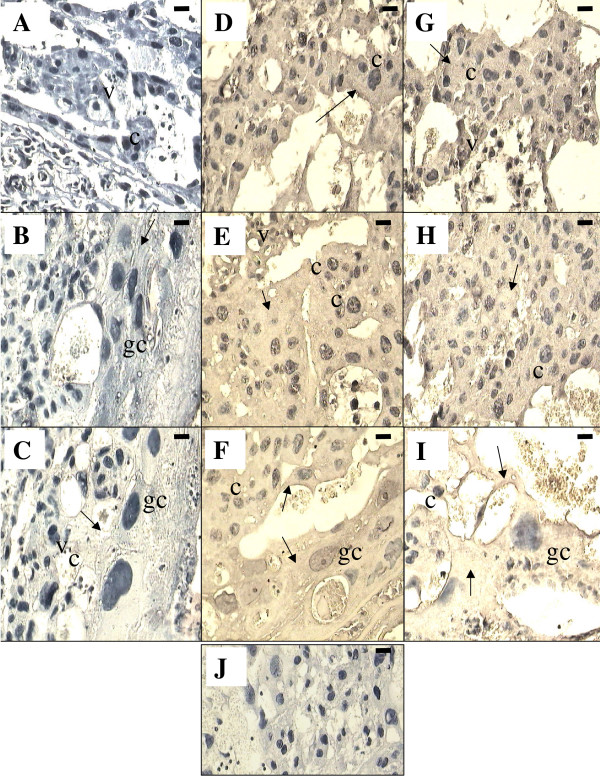
Immunohistochemical detection of caspase-3 in placental tissue in different stages of pregnancy (days 16, 19 and 21). Caspase 3 was detected using a polyclonal antibody (Santa Cruz Biotechnology, diluted 1:100) followed by incubation with biotinylated anti-goat antibody (1:500) and reaction with DAB in the presence of H2O2. The arrows indicate the cytoplasmic immunostaining of caspase-3 in trophoblastic cells. The tissue section contains cytotrophoblastic cells (c), trophoblastic giant cells (gc) and vesicular glycogen cells (v). Groups: C – control rats, corresponding to images A, B and C on the 16th, 19th and 21st day, respectively, W – tumour-bearing rats, corresponding to images D, E and F on the 16th, 19th and 21st day, respectively, and A – rats injected with ascitic fluid, corresponding to images G, H and I on the 16th, 19th and 21st day, respectively. Image J is a negative control. Magnification – 40×. Horizontal bar = 10 μm.